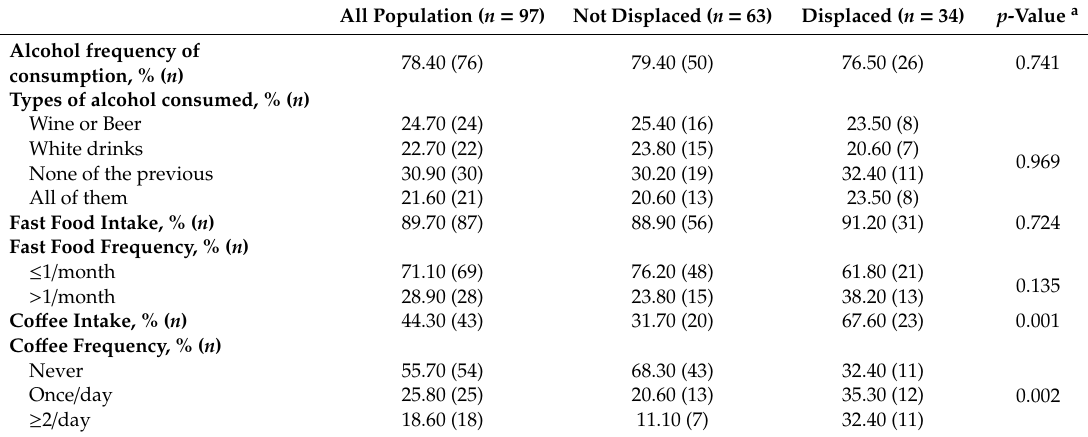
Table 2. Dietary characteristics of the study population according to whether the university students are displaced from home or not.